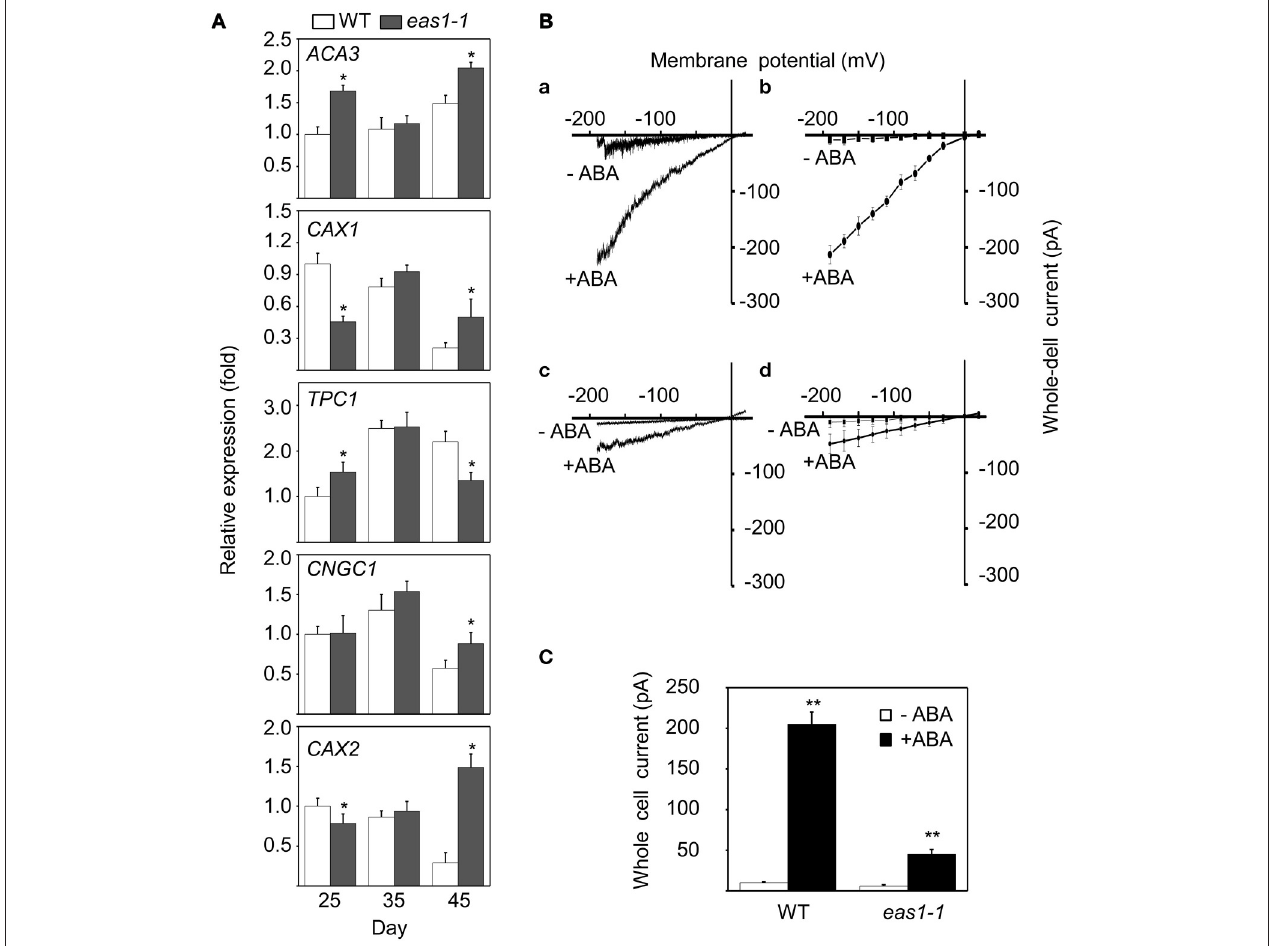
FIGURE 8 | Expression of several calcium channel genes and changes of Ca 2 + influx currents activated by ABA in guard cells. (A) mRNA expression levels of ACA3 , CAX1 , TPC1 , CNGC1 , and CAX2 in leaves from wild-type and eas1-1 mutant plants at 25, 35, and 45 days under unstressed conditions in soil. Actin was used as an internal standard. Total RNA was isolated from the sixth and seventh true leaves at the indicated time points. (B) (a,c) Whole-cell Ca 2 + influx currents in guard cells of wild-type and eas1-1 mutant plants with or without 50 µ M ABA; (b,d) Statistical analysis of Ca 2 + channel currents in (a,c) ( n = 10 ). (C) Average Ca 2 + currents at 150mV in wild-type and eas1 mutant guard cells with or without 50 µ M ABA treatment. Error bars indicate standard deviations, while asterisks indicate significant differences from wild-type plants under Student’s test ( * p < 0.05 , ** p < 0.01 ); three experiments were performed with similar